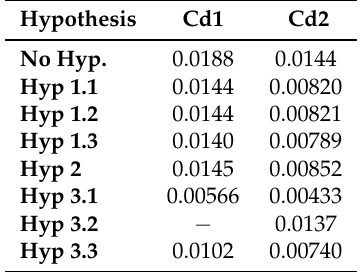
Table 3. Goodness of fit from Equation (5) of each hypothesis applied to the Cd1 and Cd2 datasets at PND21. The symbol − denotes a value no better than the control parameter set.